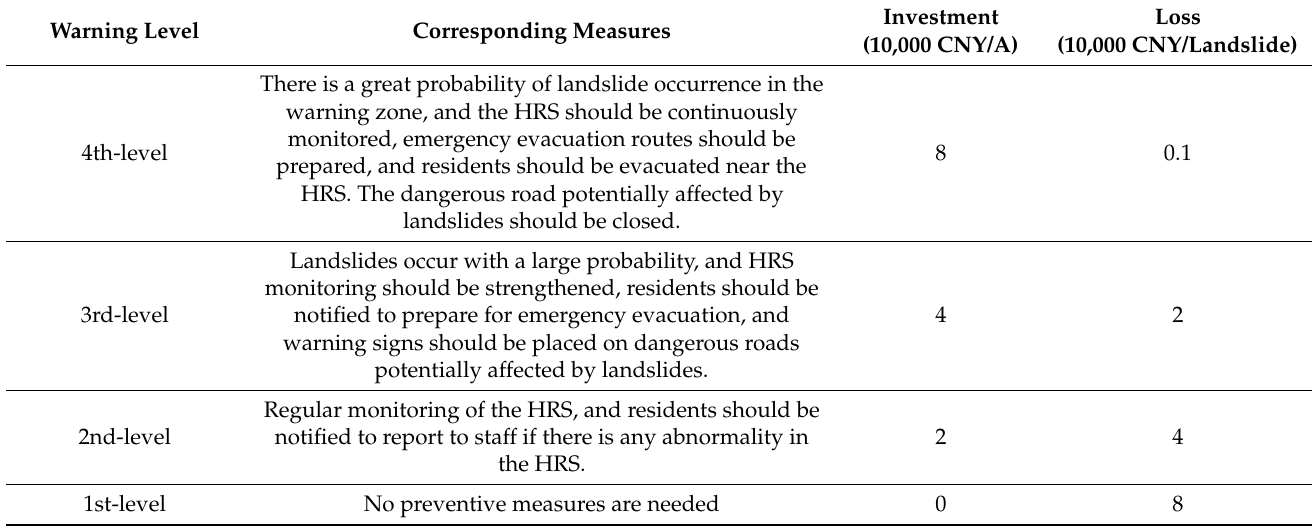
Table 1. The criteria of the response measures that need to be taken, the investment per unit area against the response measure, and the resulting loss per